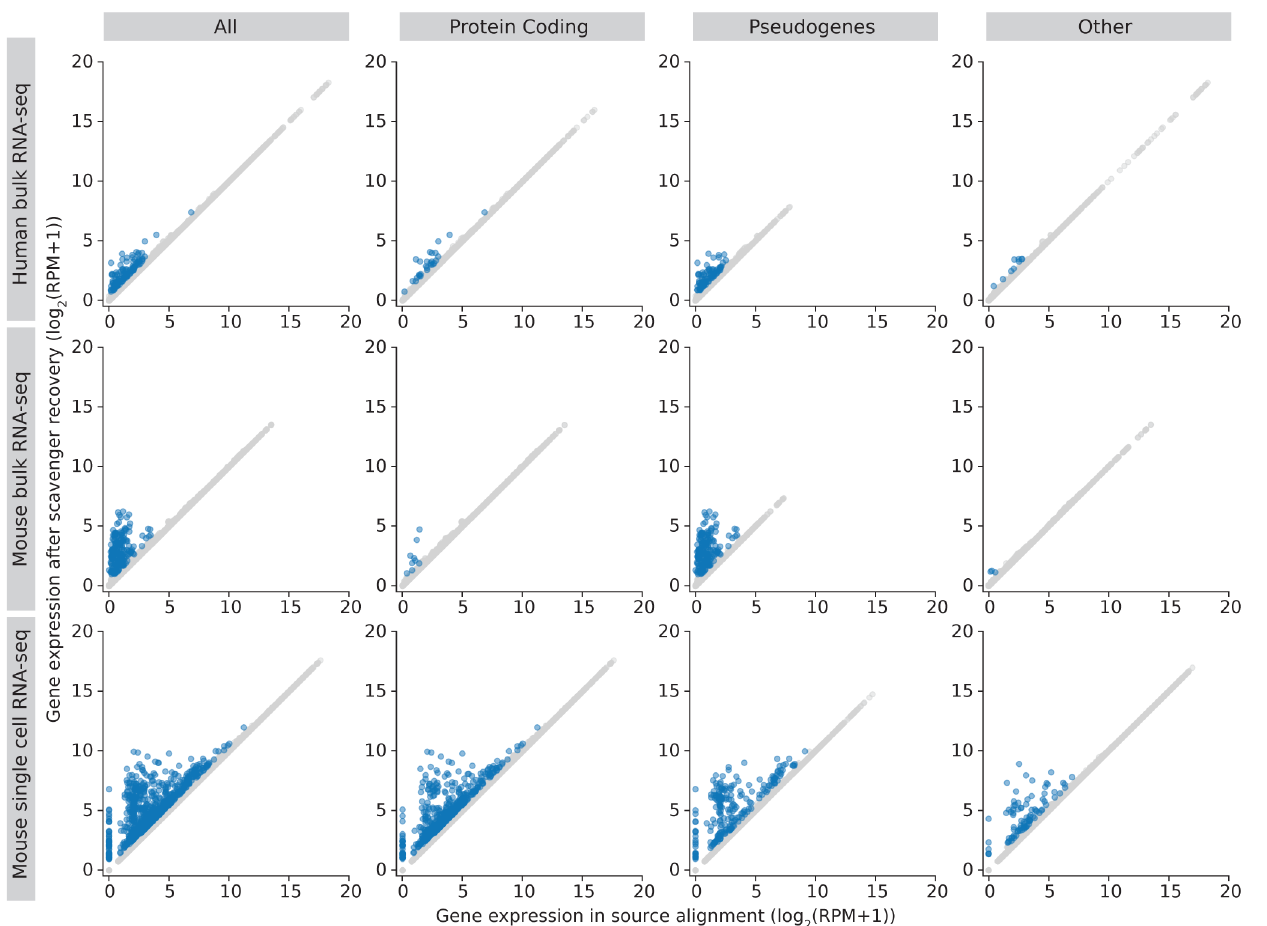
Figure 4. Gene expression in source alignment and after Scavenger recovery for genes whose reads are recovered. Coloured points indicates genes with expression difference of greater than 1 fold change.